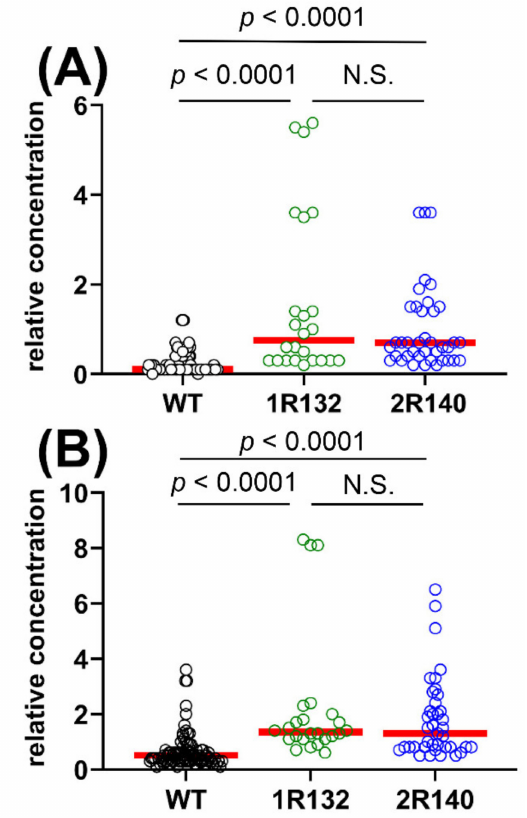
Figure 5. Statistical analysis of ( A ) 2R-HG and ( B ) 2,3-DHBA plasma concentrations in WT vs. IDH1R132 and WT vs. IDH2R140 AML patients. Both comparisons showed statistically